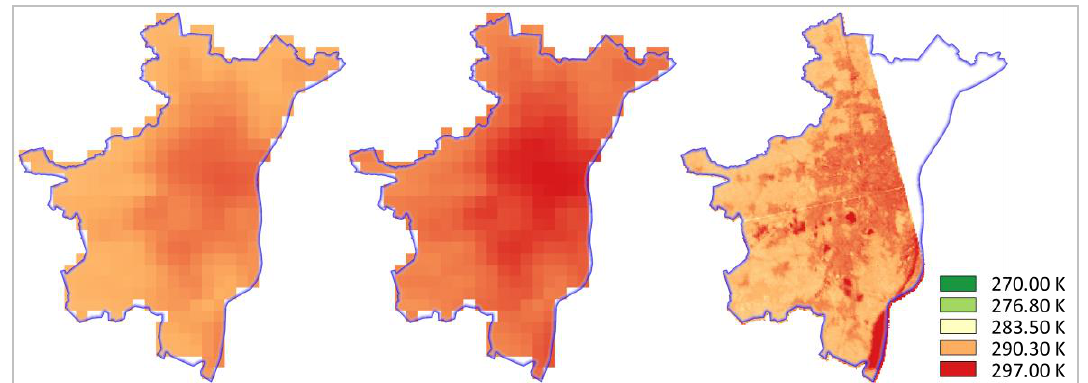
Figure 12 . Summer UHI map of Strasbourg at night when analysing all data from MODIS (left), typical days from MODIS (center), and the available data from ASTER (right)